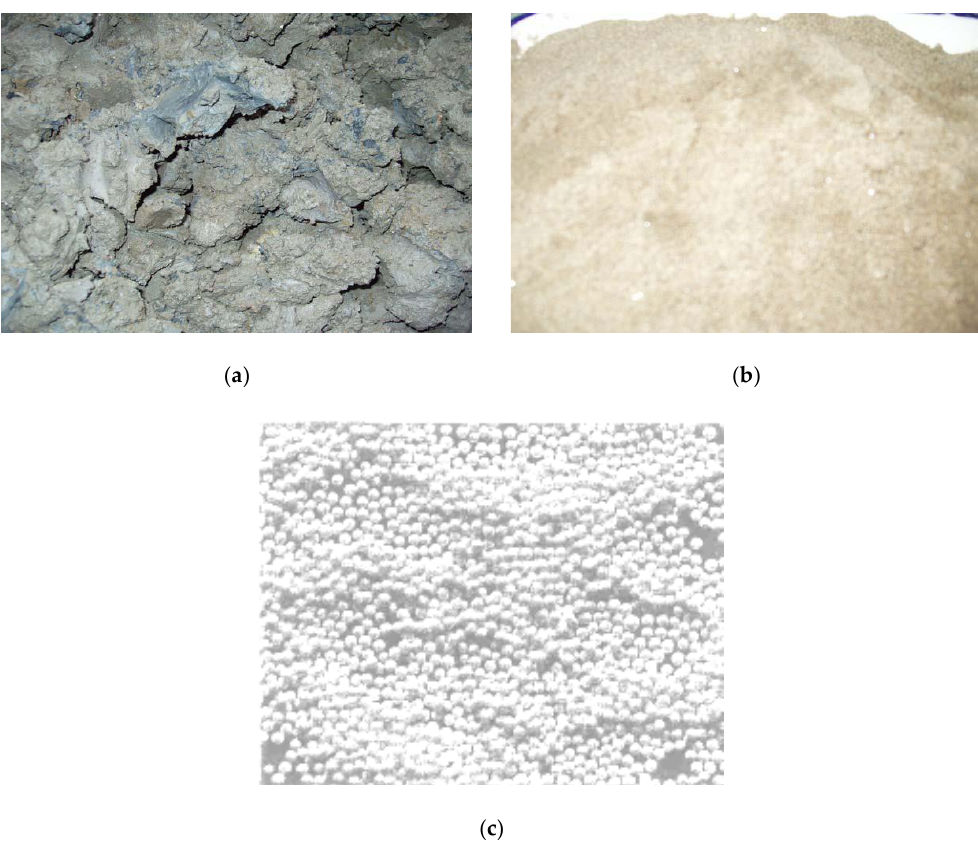
Figure 1. Test materials used in the tests: ( a ) Silty clay; ( b ) Sand; and, ( c ) expanded polystyrene (EPS) beads.